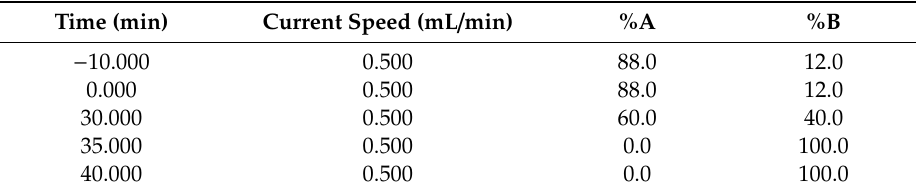
Table 1. Gradient elution conditions of mobile